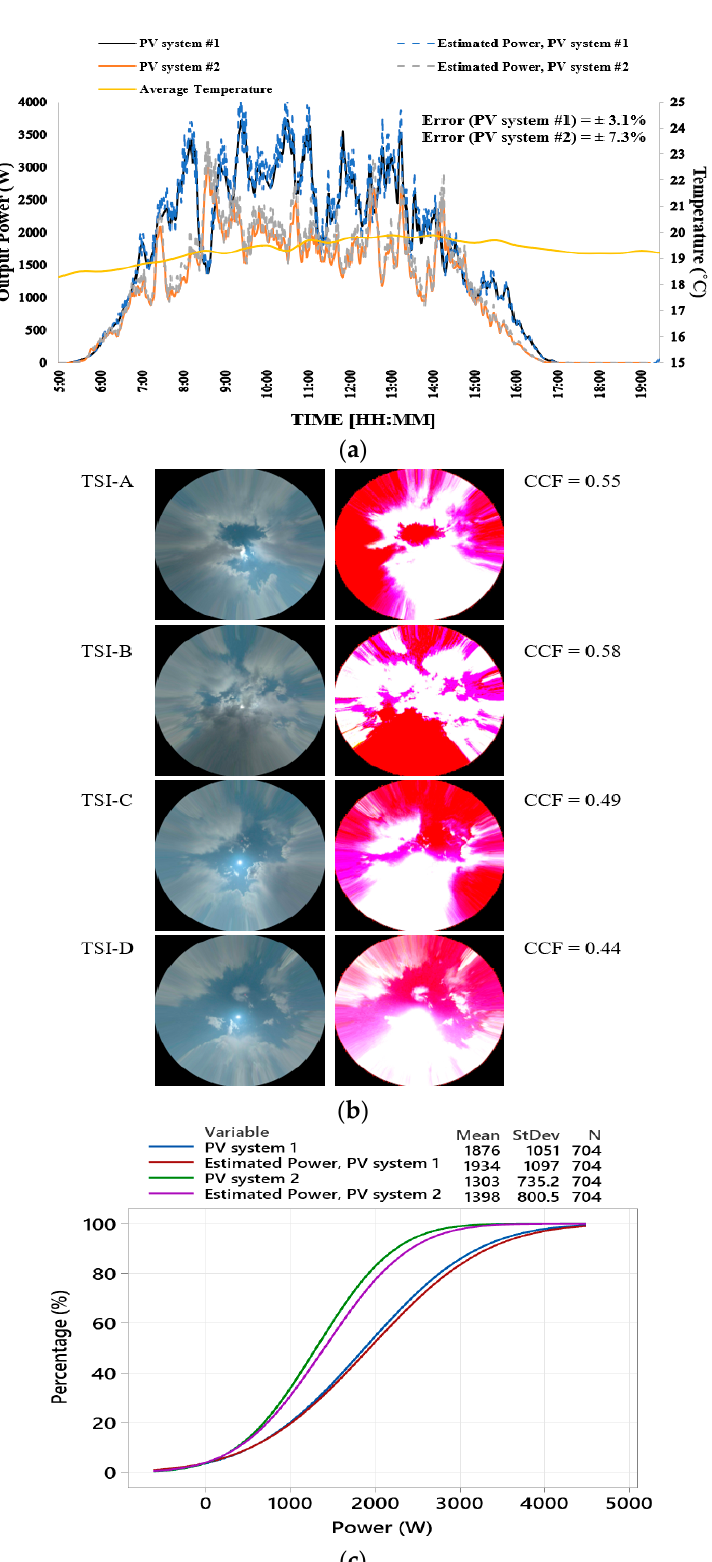
Figure 10. Output results when using the algorithm with PV systems: ( a ) output estimated power vs actual measured power in the examined PV systems (03 August 2022), ( b ) TSI image taken at 12:00, and ( c ) CDF distribution plot of the data taken from ( a ).